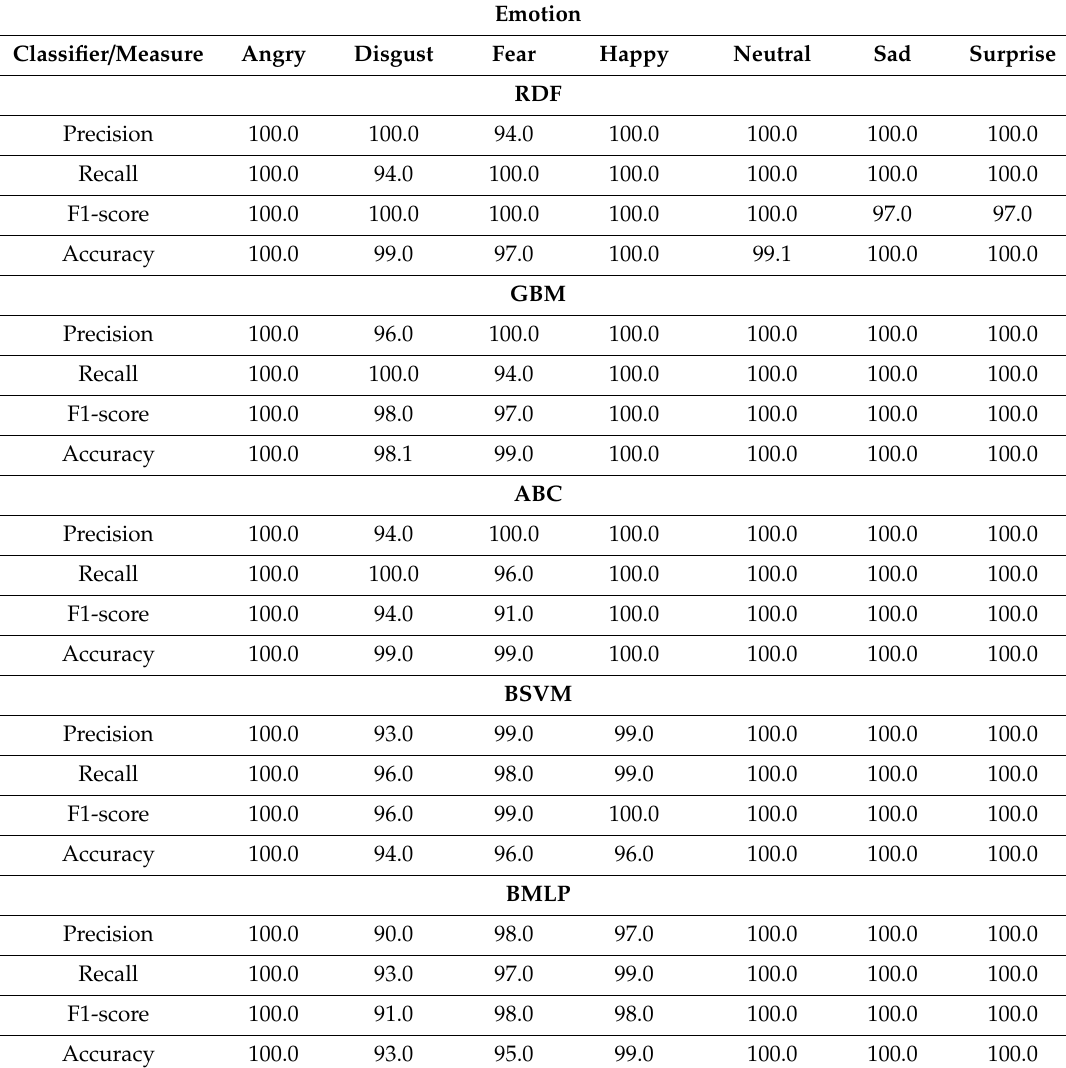
Table 10. Percentage precision, recall and F1-score and accuracy on SAVEE